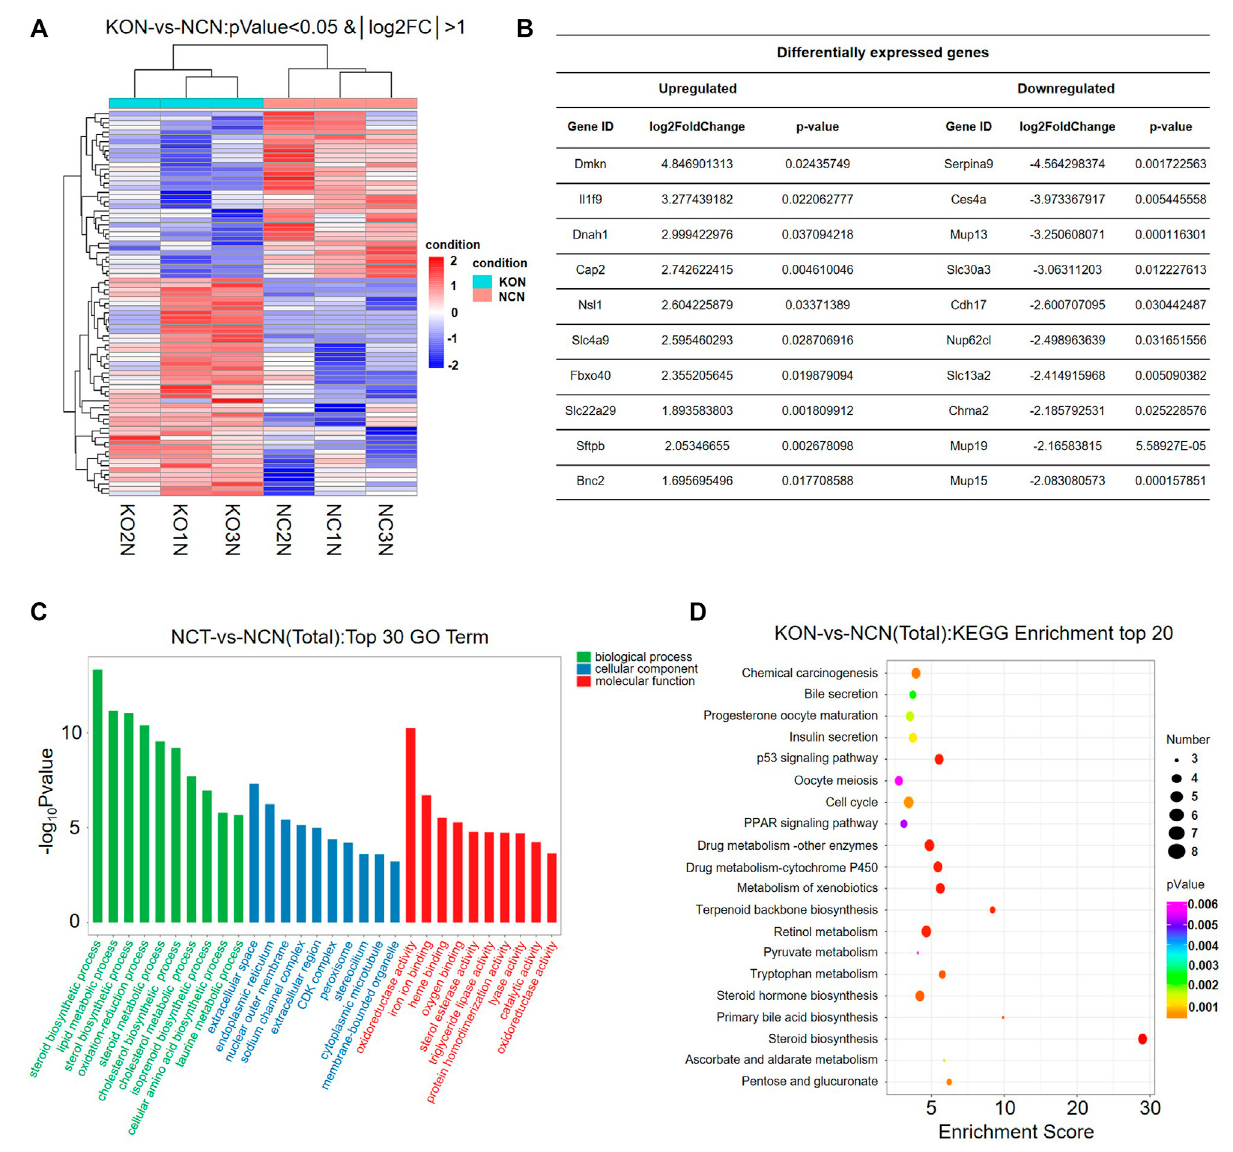
Frontiers in Molecular Biosciences |